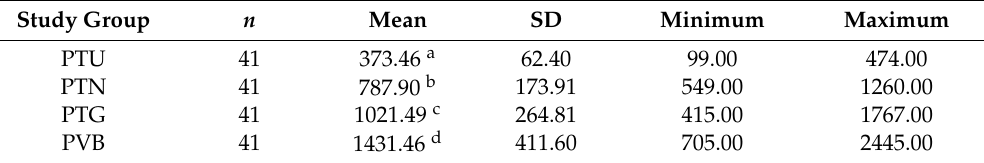
Table 3. Descriptive statistics of the number of cycles to failure of the study groups.